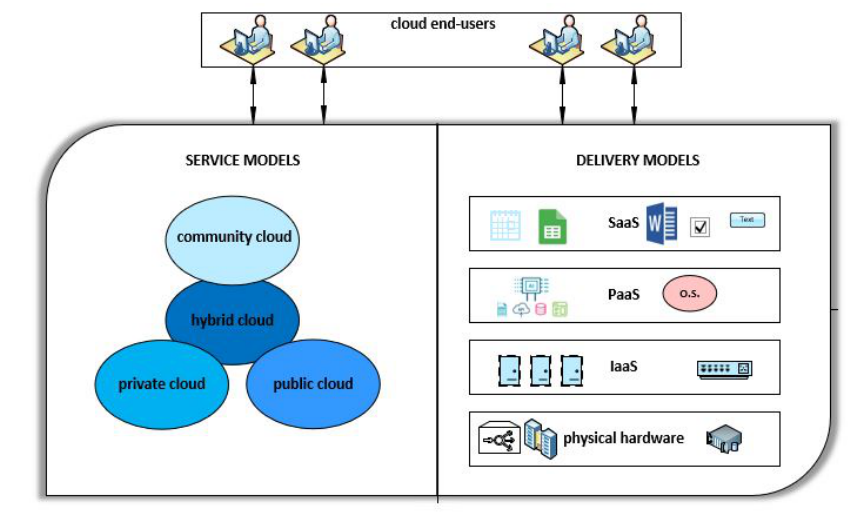
Figure 1. Taxonomies of cloud